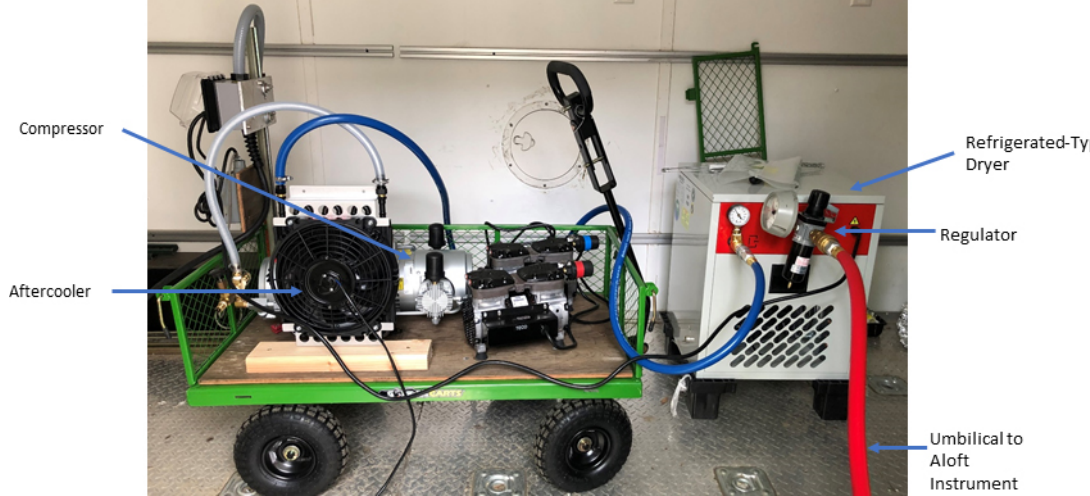
Figure 5. Dry-air generation equipment including compressor, aftercooler, dryer, regulator, and umbilical